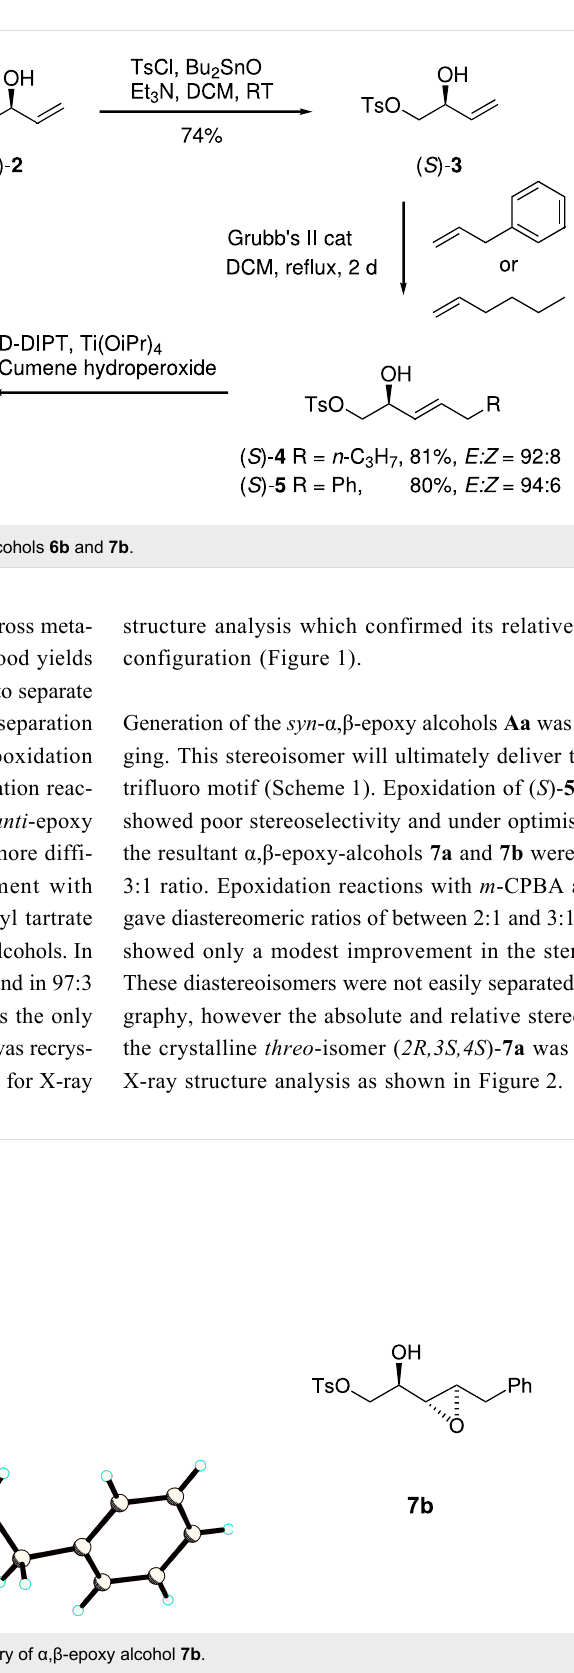
Figure 1: X-ray structure (CCDC 750307) and stereochemistry of α,β-epoxy alcohol 7b .